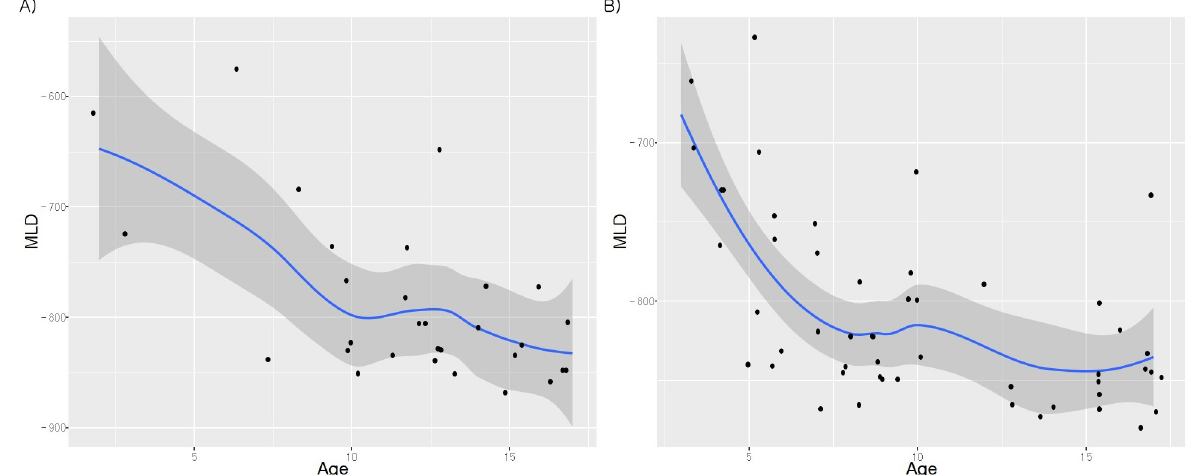
Fig 3. Scatter plot of inspiratory mean lung densities according to age for the A) control and B) bronchiolitis obliterans (BO) groups.